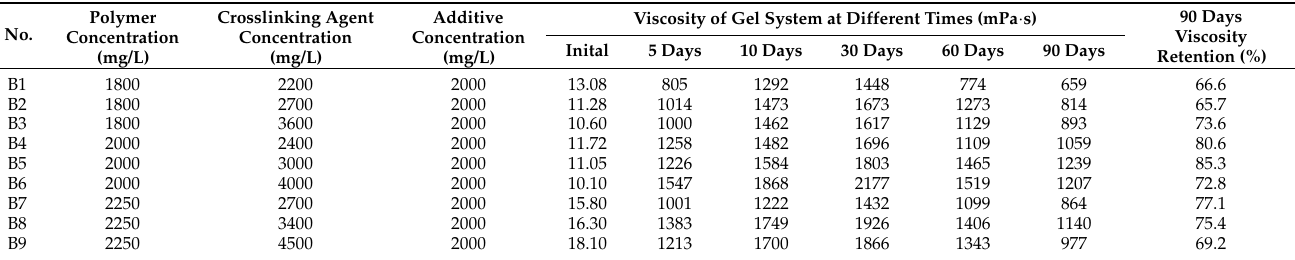
Table 2. Changes in the viscosity of the hydrophobic weak gel system recorded under conditions of varying cohesion